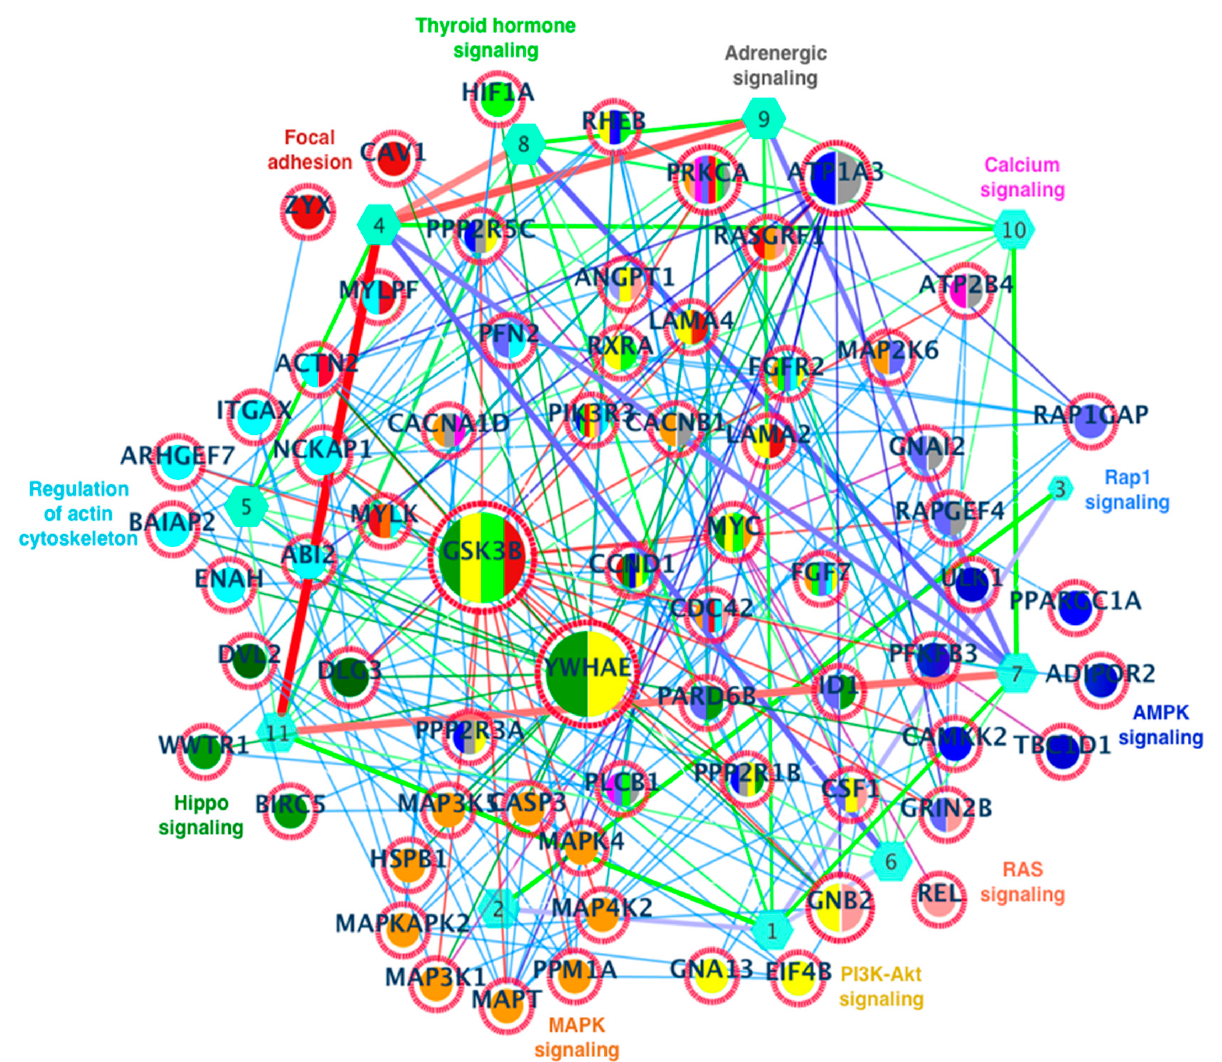
Figure 6. Crosstalk between the common enriched pathways: Pathway–pathway interactions together with the corresponding genes. The hexagonal nodes with number 1–11 represent the pathways, and the genes with more than one color mean that they are shared by more than one pathway. The higher the size of circular nodes (genes), the higher the degree of connectivity.